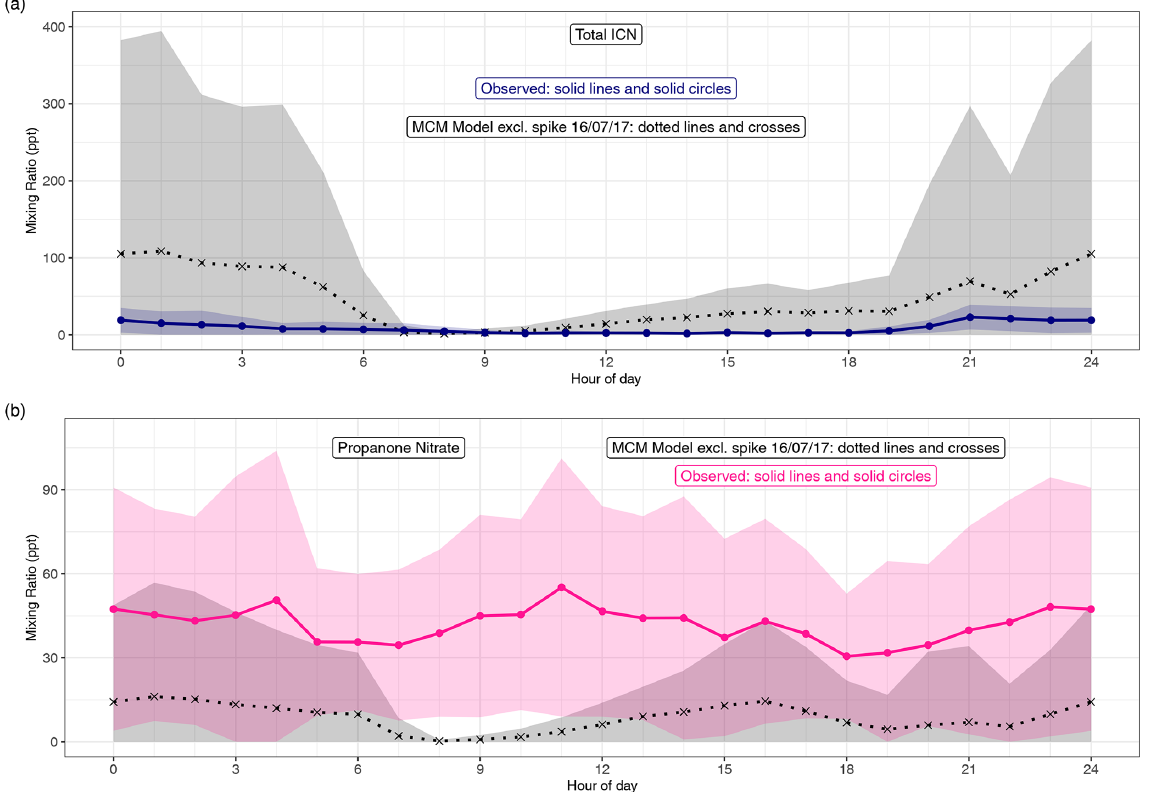
Figure 7. (a) Diel pattern of total ICN as modelled using the MCM and measured. For the MCM this is the species NC4CHO, whilst the measurements are the sum of the four δ -ICN (E and Z-(1-ONO 2 , 4-CO)-ICN and E and Z-(4-ONO 2 , 1-CO)-ICN). (b) Diel pattern of propanone as modelled using the MCM and measured. Data points are the means and the shaded areas represent ± 1 SD in the variability of values for each hour of the